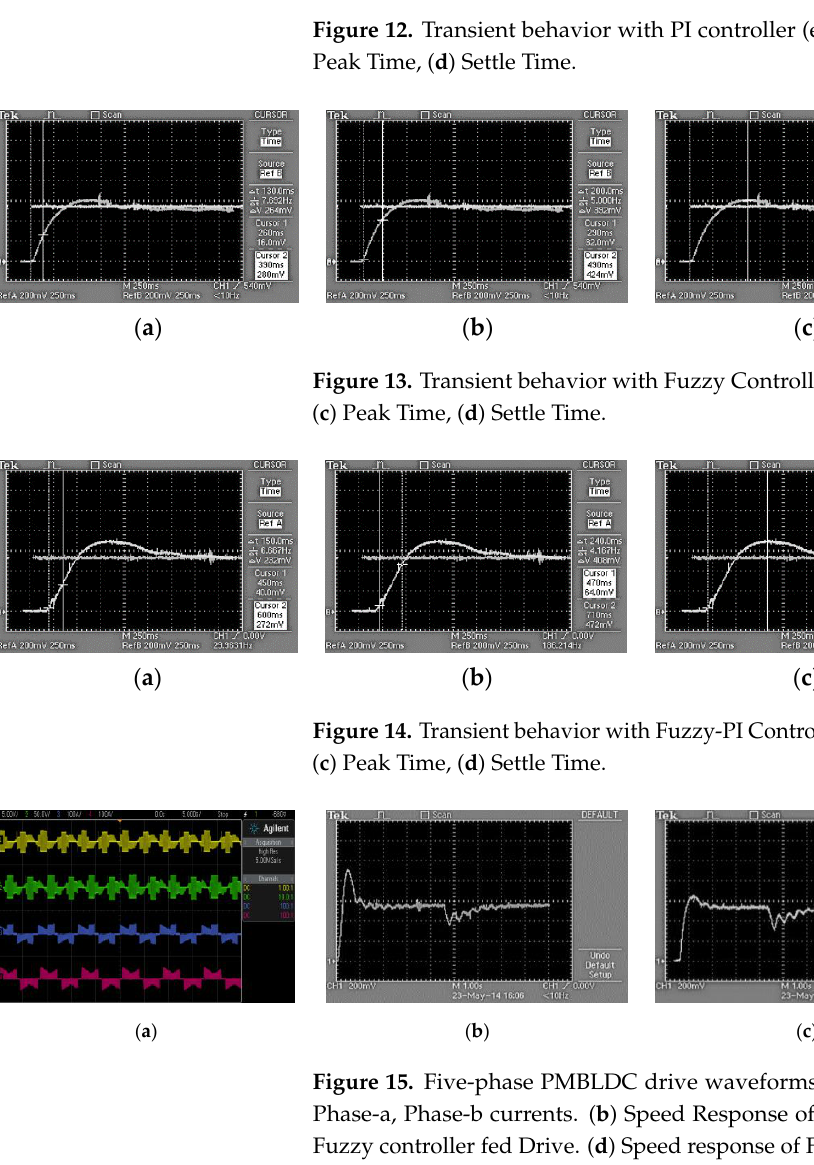
( d ) Figure 16. Overshoot Transient behavior with different controllers (Experimental). ( a ) 72 deg hall displacement at 941.1 rpm. ( b ) Overshoot with PI Controller. ( c ) Overshoot with Fuzzy Controller. ( d ) Over- shoot with Fuzzy-PI Controller. The waveforms in Figure 15a are taken from the Agilent four-channel DSO (x-3034A model) with a 10:1 probe for measuring line voltages and a 100:1 probe for measuring phase currents, respectively. The first two channels give the line-to-line voltage (V ab and V bc ) and the next two channels give the two phase currents (I a and I b ). A 2.4 V peak-to-